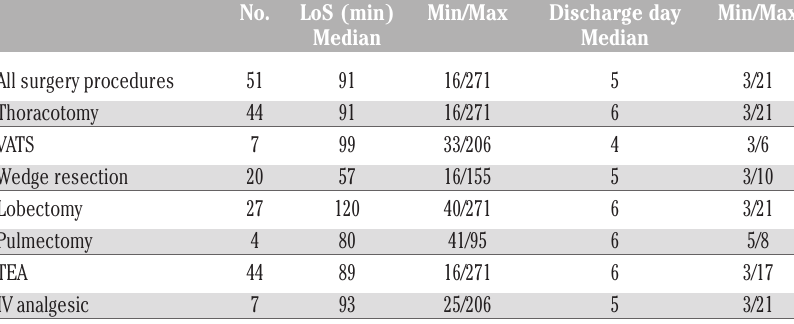
Table 2. Length of surgery and discharge